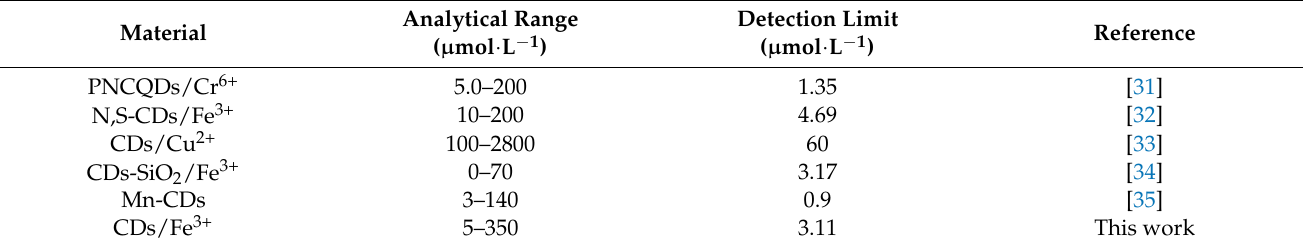
Table 1. Comparison of previously reported fluorescent methods for ascorbic acid detection with the present method.